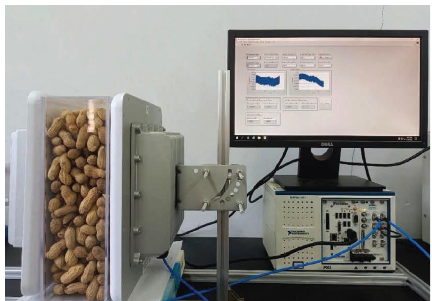
Figure 1: Te test platform used to assess peanut moisture